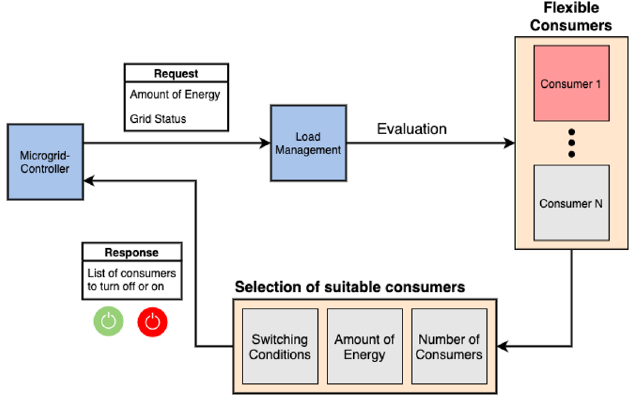
Fig. 4. Outline of a load